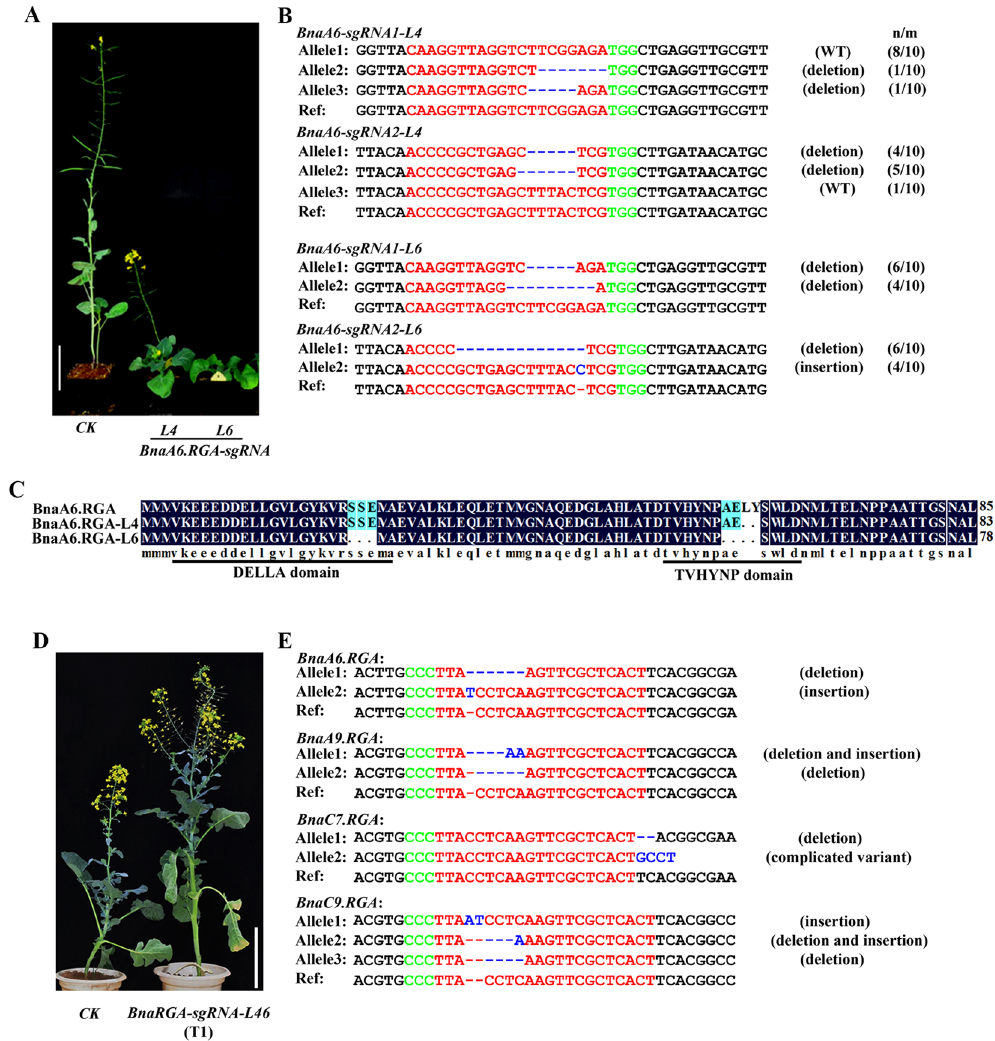
Figure 3. Phenotype and genotype of a BnaA6 . RGA-sgRNA single mutant (T0) and a BnaRGA-sgRNA quadruple mutant (T1). ( A ) Morphology of BnaA6 . RGA-sgRNA transgenic plants at the same age. L4 and L6: two individual T0 transgenic lines. CK: BnaA6 . DA1-sgRNA (L10). Bar = 15 cm. ( B ) Genotype of BnaA6 . RGA- sgRNA lines (L4 and L6) in the T0 generation. ( C ) Amino acid sequence alignment of the target sites derived from WT and two BnaA6 . RGA-sgRNA transgenic lines (L4 and L6). The DELLA and TVHYNP domains are underlined. The amino acid deletion in the DELLA domain is caused by sgRNA1. The amino acid deletion in the TVHYNP domain is caused by sgRNA2. ( D ) Image showing the morphology of the quadruple mutant induced by BnaRGA-sgRNA (L46-T1) at the same age as the control. CK: WT plant. Bar = 15 cm. ( E ) Genotype of the quadruple mutant isolated from BnaRGA-sgRNA-L46 in the T1 generation. The PAM sequence is indicated with green. The sgRNA is indicated with red. The mutation sites are indictaed with blue. For the term n/m, m indicates the number of clones examined, and n indicates the number of clones showing the indicated CRISPR/Cas9-induced mutations are stable and inheritable in B . napus . B . napus is an allotetra- ploid crop 31 . Given the high ploidy level, it is interesting to test whether the mutations caused by CRISPR/Cas9 are stable and inheritable in B . napus . A total of 323 T1 plants derived from the T0 (Table 3) were examined for the genotypes at the target sites (Table 4; Supplemental Table S3). Due to the large number of samples, sequencing results from the entire set of DNA amplicons were directly decoded by DSDecode. Therefore, only homozygotes, wild type, bi-alleles and heterozygotes were clearly identifiable. We could not accurately decode chimeras using this approach. Thus, chimeras are indicated with an ‘h’ for heterogeneous (Table 4). The T1 progeny of 3 T0 homozygotes were still homozygous with the same mutations, indicating that the mutations in these transgenic lines were stable (Table 4). If the bi-allele and heterozygous genotypes are inherited normally, the segregation ratio is expected to be 1xx:2xy:1yy. However, unexpected segregation ratios of 0:2:13, 3:12:0, 0:20:0 and 11:1:2 were observed among the T1 progeny of BnaDA2-sgRNA2-L12 (targeted to BnaA2.DA2 ), BnaDA2-sgRNA1-L20 (tar- geted to BnaC6.DA2 ), BnaRGA-sgRNA1-L27 (targeted to BnaA9.RGA ) and BnaC5.DA1-sgRNA-L1, respectively